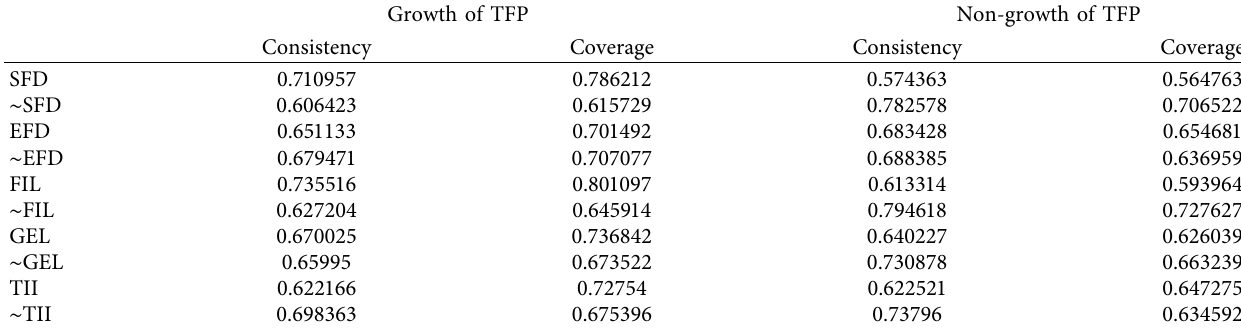
Table 5: Necessity test results of conditional variables.